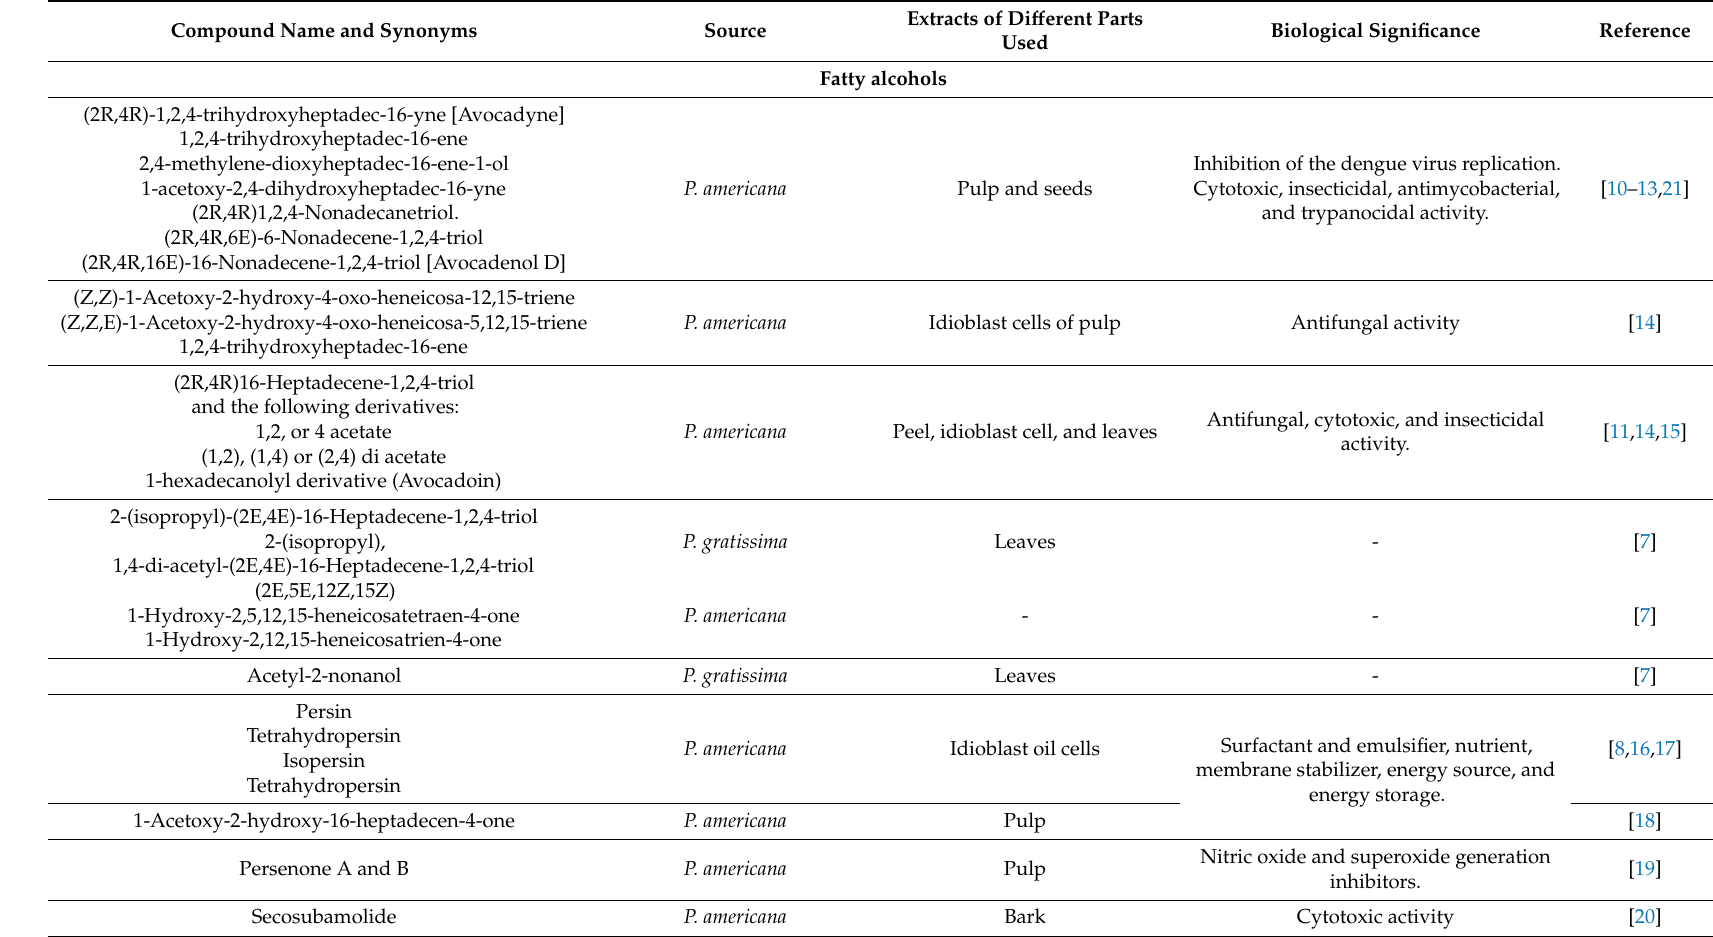
Table 1. Metabolites isolated from Persea